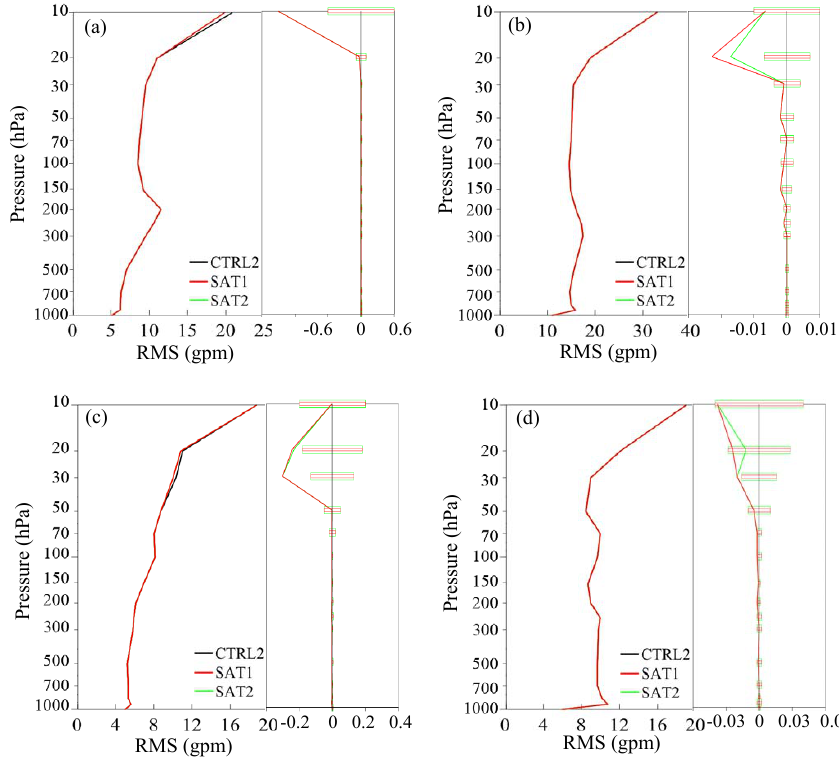
Figure 15. (a) RMS of geopotential height from the analysis field difference between CTRL2 and NCEP (black), SAT1, and NCEP (red), SAT2 and NCEP (green) in the (a) Northern Hemisphere, (b) Southern Hemisphere, (c) the tropics, and (d) East Asia during 1–27 July 2014. The statistical significance testing of SAT1 and CTRL2 (SAT2 and CTRL2) are shown in the right part of each figure in red (green). The RMS differences outside of outline bars are significant at the 95% confidence level. Table 4. The given observation errors (K) of AMSU-A (numbers 1–7 indicate AMSU-A channels 5–11) and MWTS-2 (numbers 2–5 indicate MWTS-2 channels 5–8) in GRAPES